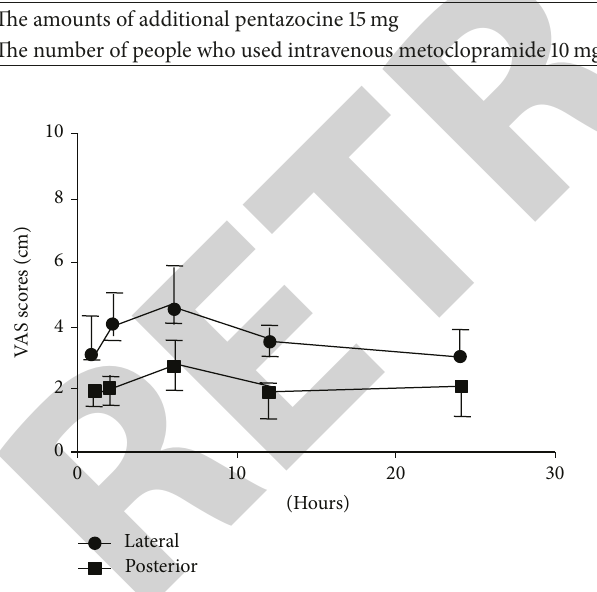
Table 4: Postoperative dates except some VAS scores: data of the amounts of additional pentazocine expressed as average (standard deviation) and amounts of the intravenous metoclopramide expressed as frequency with percentages (%). Lat. TAP group ( 𝑛 = 34 )